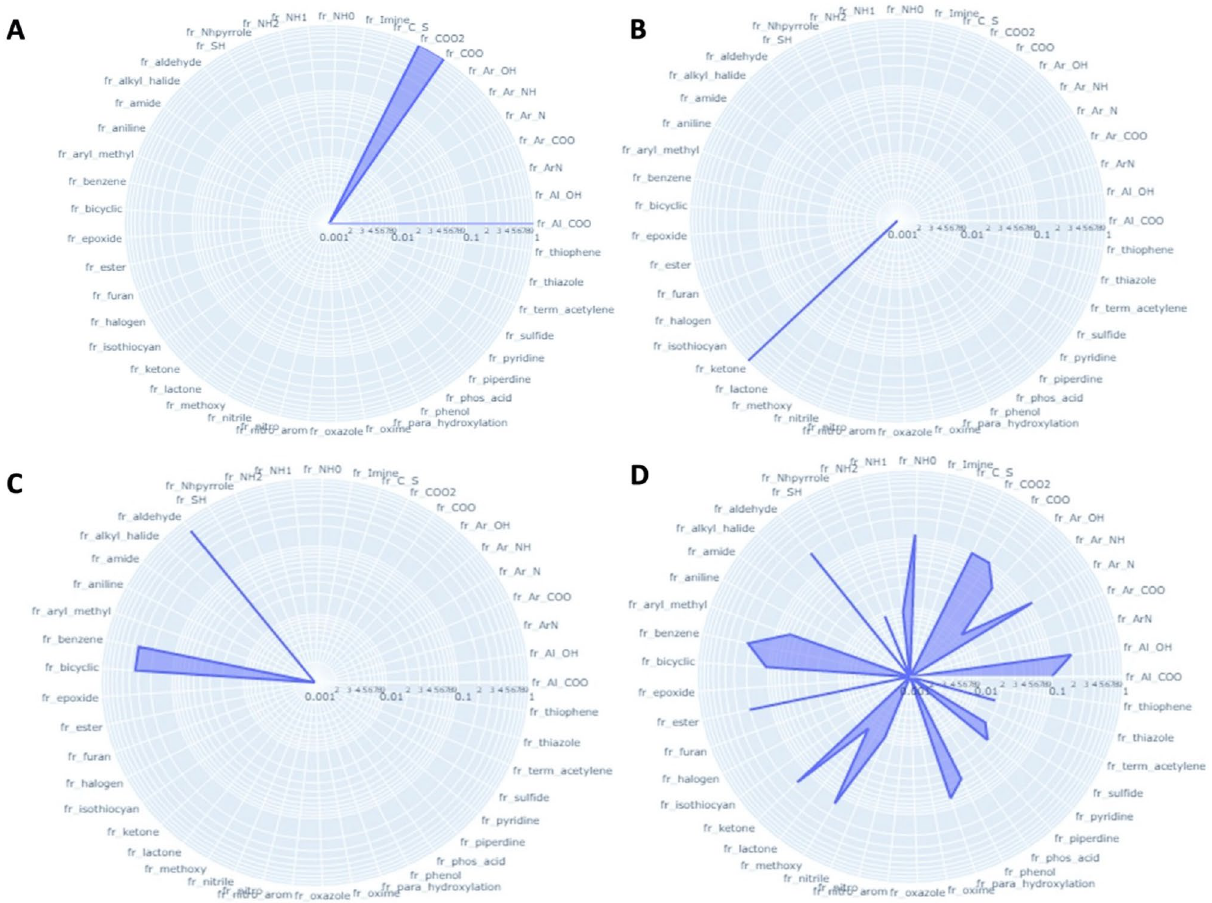
Figure 5. Radar plot based on the frequency of physicochemical properties observed on the set compounds associated to an olfactory receptor. ( A ) OR52E1, ( B ) OR4D6, ( C ) OR1D3, ( D ) OR1G1. The radarplots were developed with the python package plotly (v.5.3.1): https:// plotly. com/ 61 .